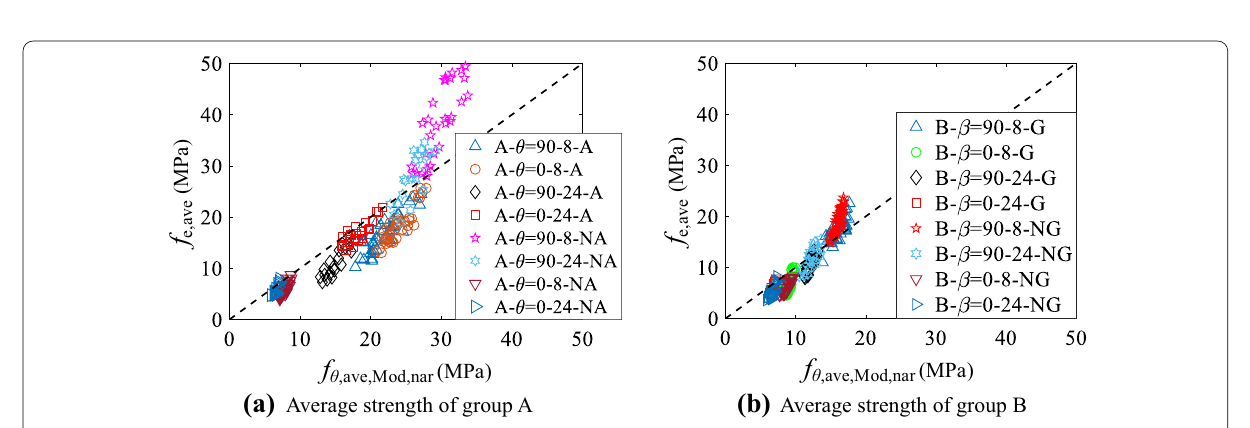
Fig. 19 Verification of the modified empirical equations